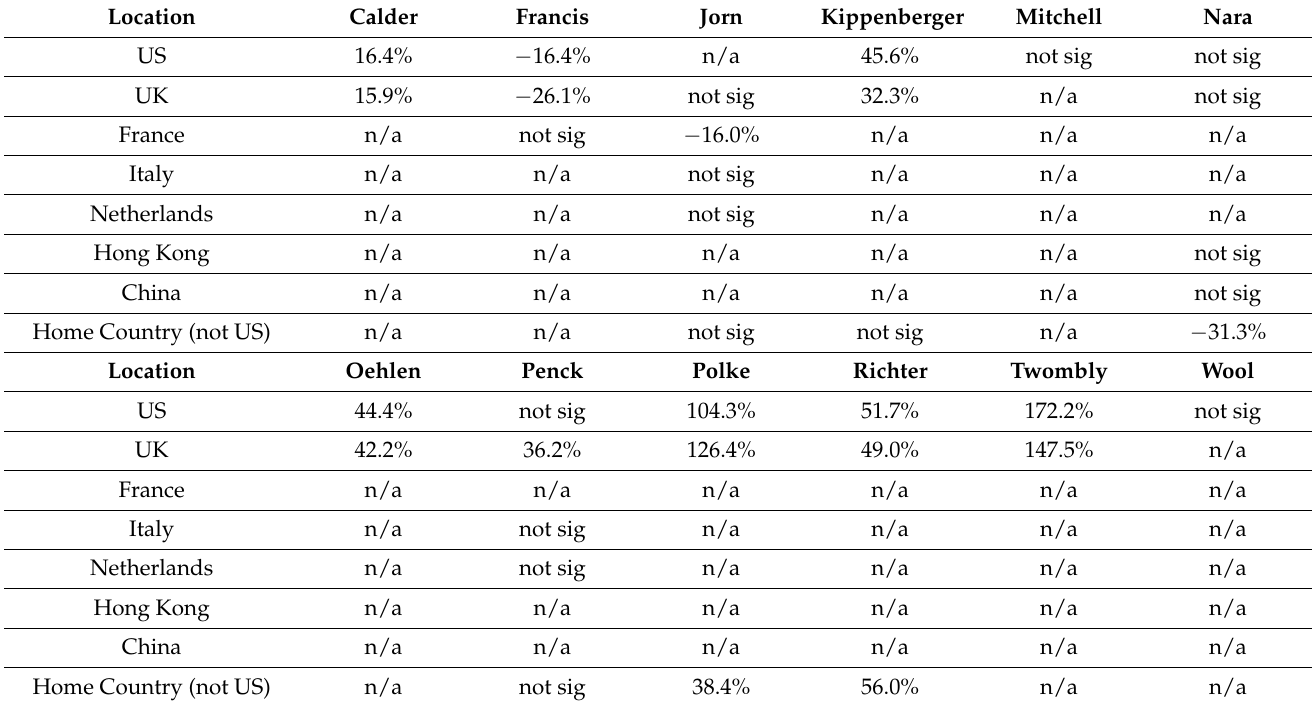
Table 6. Percentage change in price through selling in a location compared to those locations not included in the